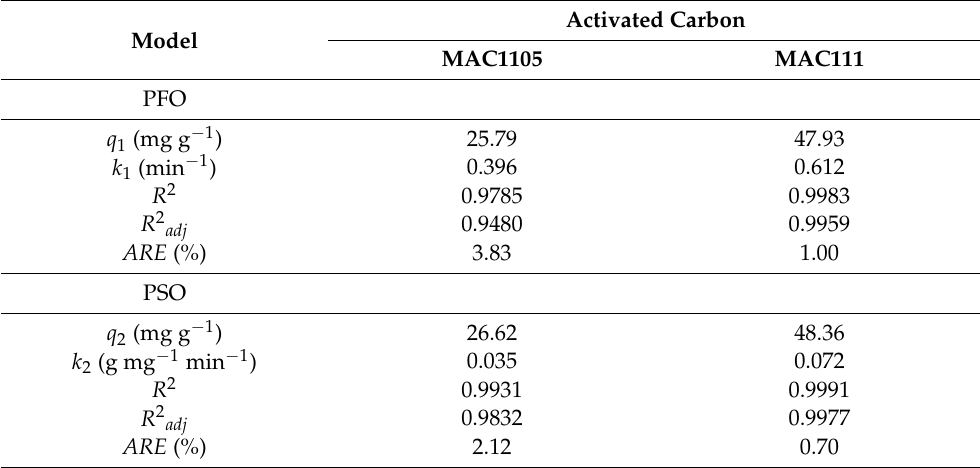
Table 3. Kinetic parameters for the adsorption of BB dye.